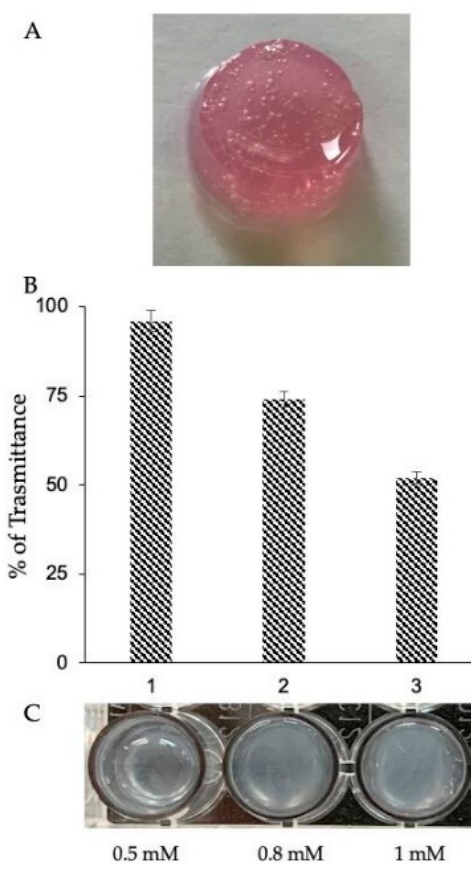
Figure 4. Stable and injectable combined marine hydrogel. ( A ) Production of injectable hydrogel totally from marine source (Marine Collagen hydrogel (MCh)) by mixing (1:1) JFC in native form and functionalized denatured collagen (Gtn-HPA) obtained by the reaction of HPR 2 U / mL and 0.5 mM H 2 O 2 . The use of the lower concentration of H 2 O 2 minimizes the possible toxicity of the system. The hydrogel formulation has shown perfect flow from 23 G and thicker-sized syringes. ( B ) Determination of hydrogel sti ff ness degree by transmittance analysis. The higher density of the gel, due to a higher cross-linking number, is inversely proportional to the percentage (%) of transmittance. The solution of MC uncross-linked was used as control. Transmittance was read at 700 nm. Bars represent mean ± SD ( n = 3). In correspondence with the histogram, the relative images of the hydrogel ( C ) show how the increase in H 2 O 2 concentrations, from 0.5 to 1 mM, augmented the number of cross-linking and the opacity of the